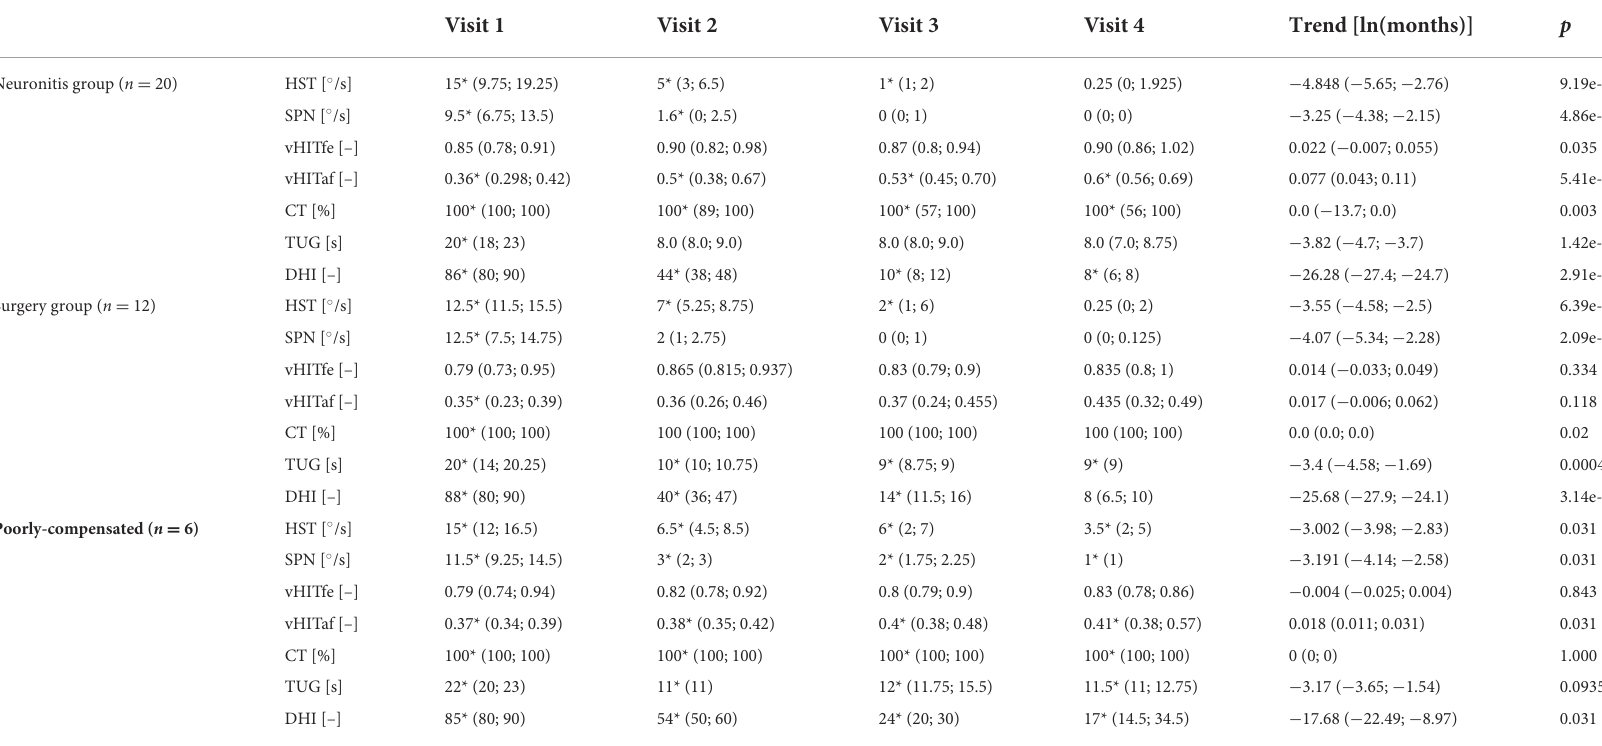
TABLE 1 Groups results: For the vestibular tests the medians and lower and upper quartiles are shown (HST, head-shaking test; SPN, spontaneous nystagmus; vHITfe(af), video head impulse test on affected (fellow) side; CT, caloric test; TUG, timed up and go test; DHI, dizziness handicap